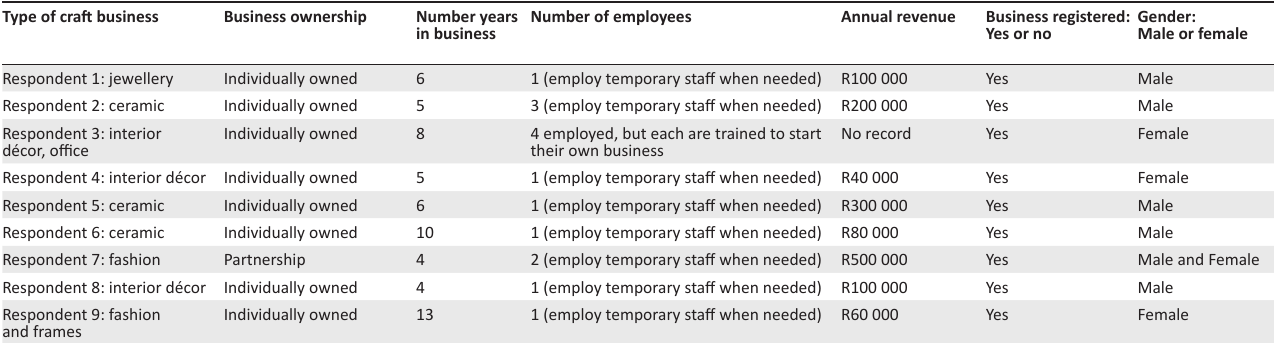
TABLE 1: Business profile of the businesses